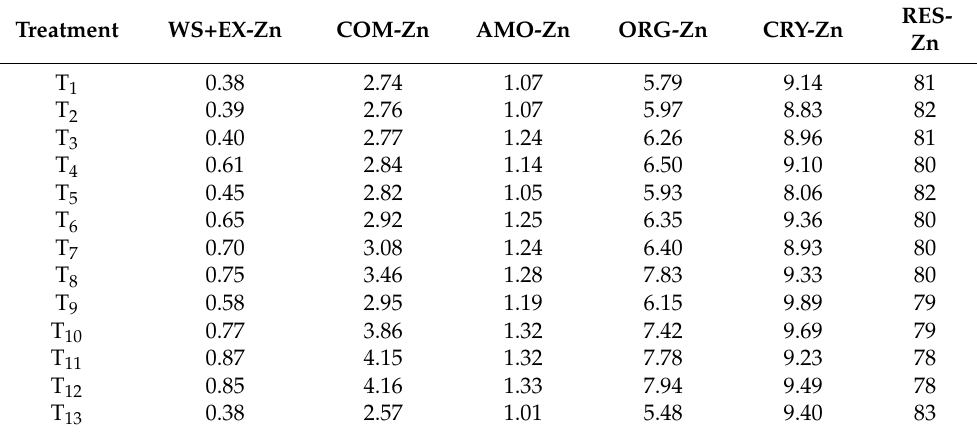
All zinc fractions’ abbreviation and treatments details are available in Table 2. The percent distribution in the remaining all fractions increased with Zn load. The percent concentration of Zn in different pools increased as per different frequencies of Zn application according to the following order, initial year-application < alternate years- application < every year-application (Table 4). The relative increment in Zn concentration in alternate years and every year over the initial year of Zn application was about 48% and